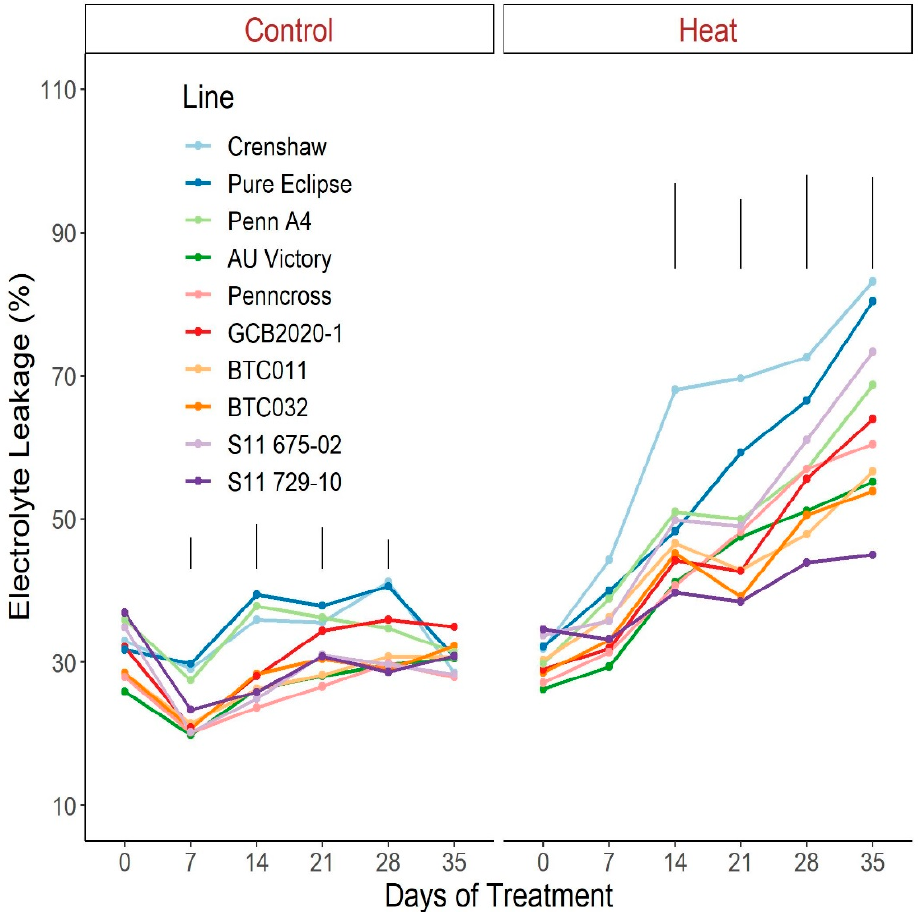
Figure 10. Change in electrolyte leakage for creeping bentgrass lines over time under control (20/15 °C day/night) and heat stress (38/33 °C day/night) conditions. Bars represent LSD values at p = 0.05 on days when significant differences among lines were found.